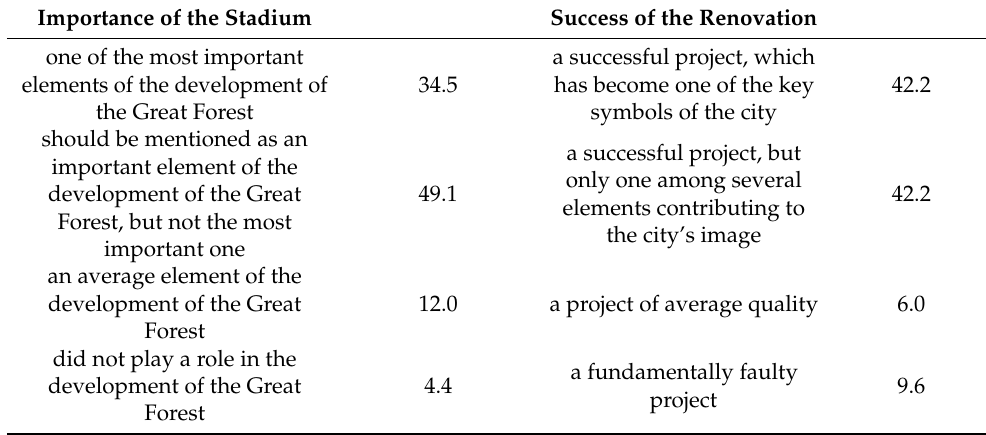
Table 3. Opinions of local residents on the Great Forest Stadium development (%).